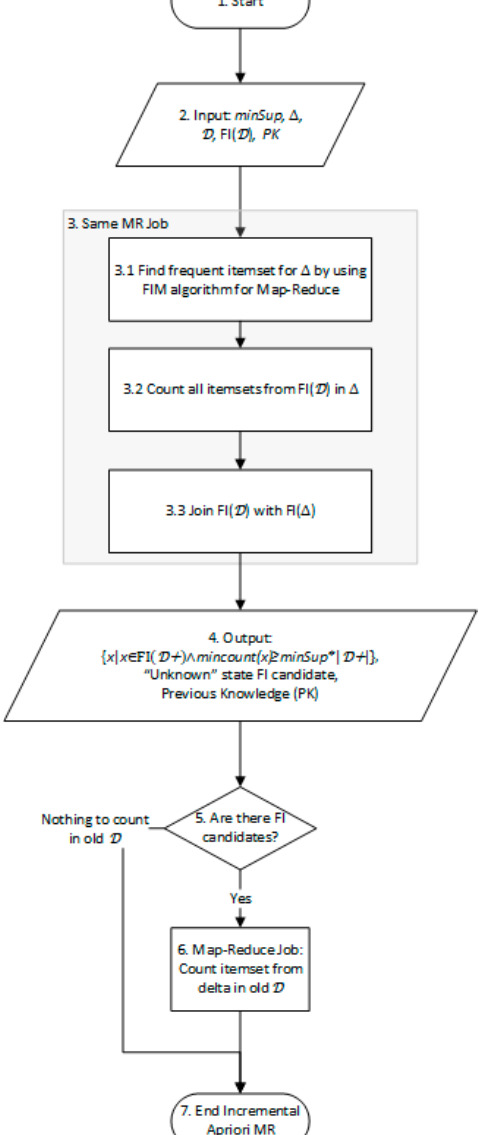
Figure 8. Optimized incremental algorithm with reduced overhead.